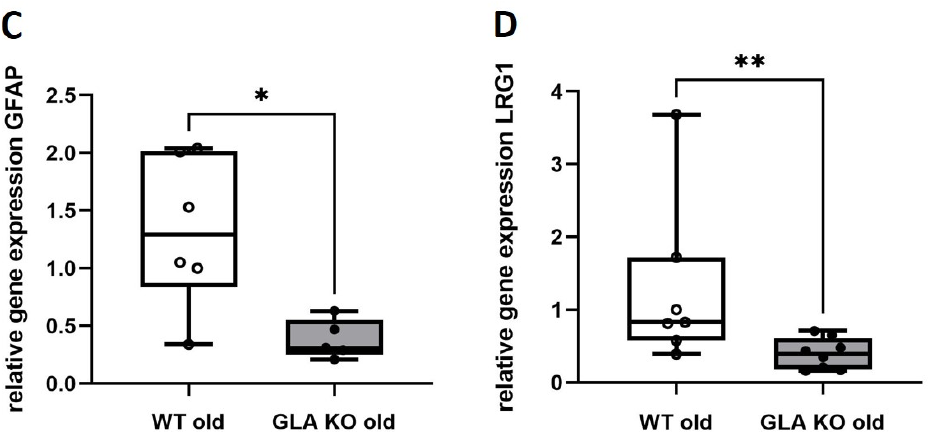
Figure 5. qRT PCR analysis of inflammation-associated targets IL1b, IL10, GFAP, and LRG1. ( A – D ) Relative gene expression of IL1b (( A ), WT old n = 7, GLA KO old n = 8), IL10 (( B ), WT old n = 7, GLA KO old n = 8), GFAP (( C ), WT old n = 6, GLA KO old n = 5), and LRG1 (( D ), WT old n = 7, GLA KO old n = 8) in DRG of old WT ( ) and old GLA KO mice ( • ). Abbreviations: DRG = dorsal root ganglia; GFAP = glial fibrillary acidic protein; GLA KO = alpha-galactosidase A knockout; IL = interleukin; LRG1 = leucine-rich alpha-2-glycoprotein 1; qRT PCR = quantitative real-time polymerase chain reaction; WT = wildtype. * p < 0.05, ** p < 0.01, *** p < 0.001.